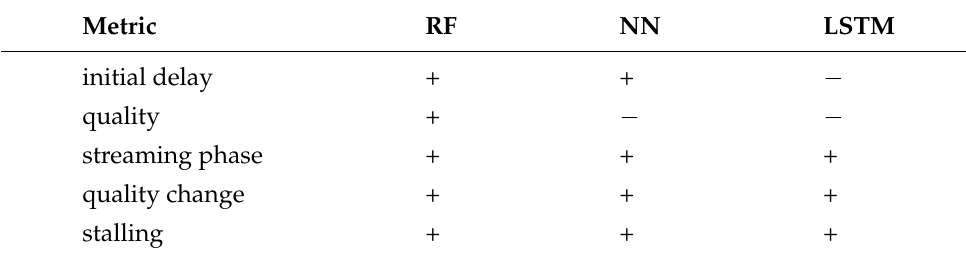
Table 10. Machine learning